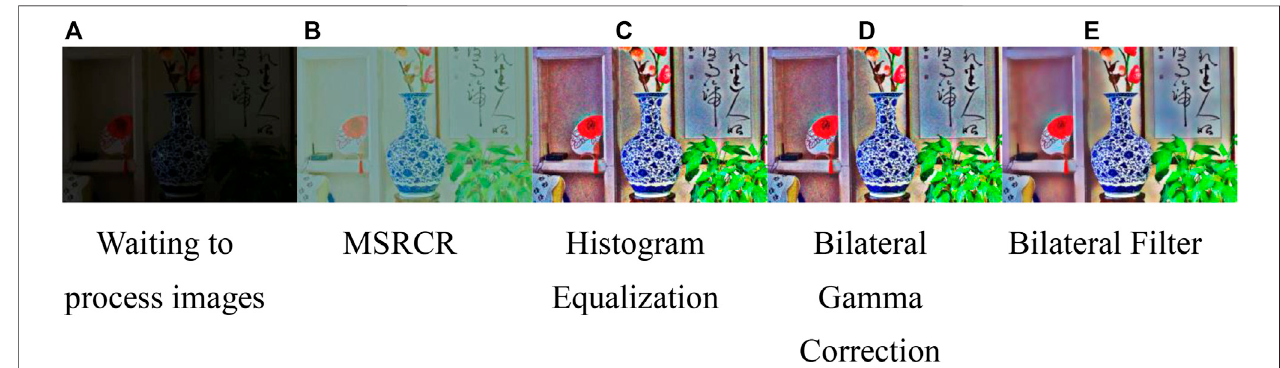
FIGURE 6 | The results of compensation layers obtains. (A) Waiting to process images (B) MSRCR (C) Histogram Equalization (D) Bilateral Gamma Correction (E) Bilateral Filter.